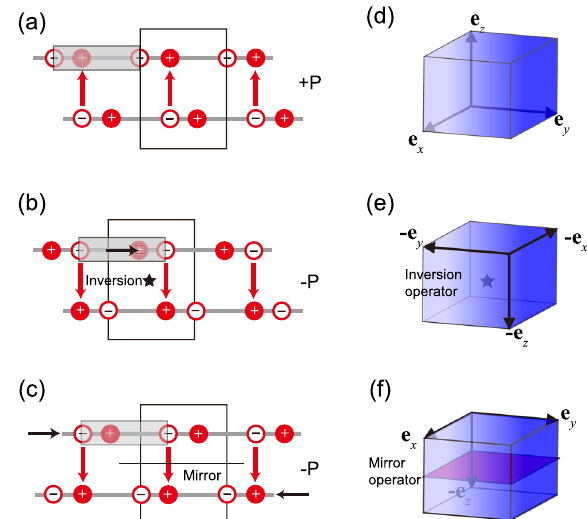
Fig. 1 Polarization fl ipping in a 2D vdW bilayer material via intralayer movement or interlayer sliding, and related symme- tries. a A 2D system with positive out-of-plane polarization + P . b The polarization is reversed to – P by atom displacements in each monolayer, and the black arrow means the movement of the cations relative to the anions. c The polarization is reversed by interlayer sliding and the black arrows mean the interlayer sliding direction. d Three basis vectors and their transformations under e inversion symmetry f horizontal mirror symmetry. The black rectangles denote the bilayer unit cells in (a)-(c), and the gray rectangles denote the monolayer unit displacements in each monolayer [Fig. 1b], and (ii) interlayer sliding 15 where the crystal structure of each monolayer is invariant [Fig. 1c]. Although polarization fl ipping can be achieved in both situations, the underlying symmetries of the switch of ferroelectric states are different. For situation (i), the + P and – P ferroelectric states are correlated by the inversion operator, as indicated in unit cells in Fig. 1a, b. While for situation (ii), the + P and – P ferroelectric ^ states are correlated by the mirror symmetry M xy , as seen in unit cells in Fig. 1a, c (detailed analyses are presented in the Symmetry analysis section for real materials). The interlayer sliding mechan- ism is feasible experimentally and has been observed in bilayer vdW materials 16 – 25 as stated above, which further extends the family of 2D ferroelectric materials 26 – 29 effectively. Figure 1d – f sliding ferroelectric materials do not always change synchronously with the ferroelectric order.